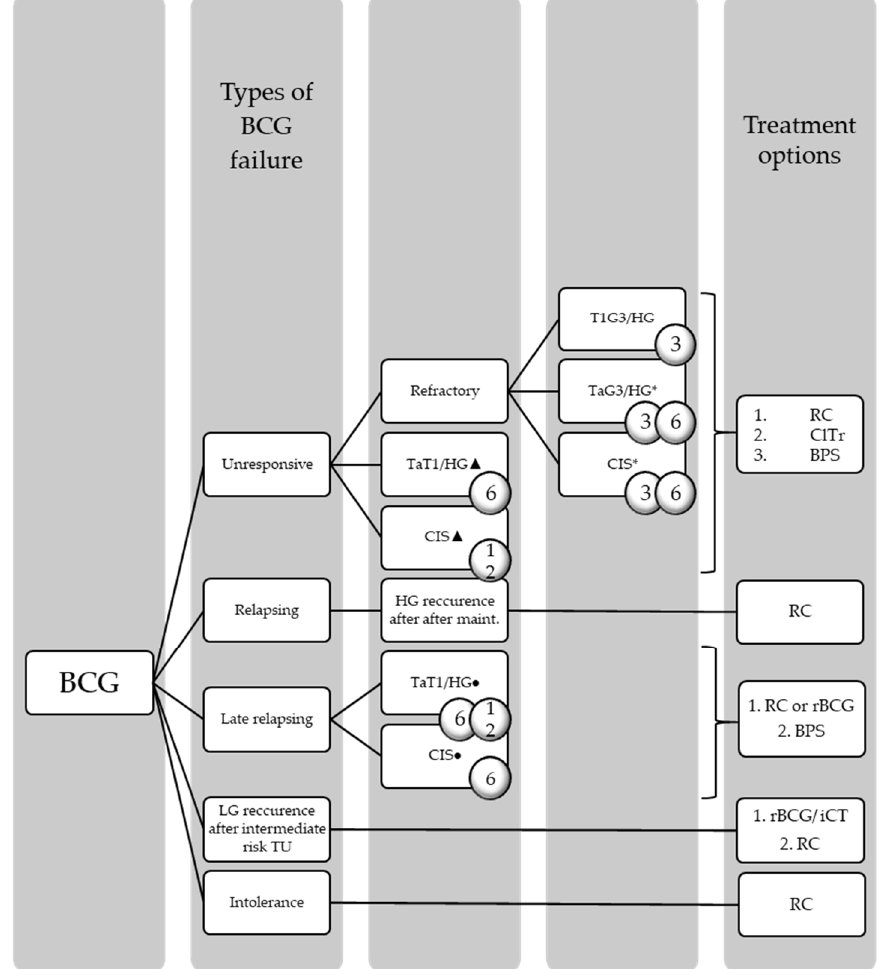
Figure 1. Types of BCG failure and treatment recommendations according to the EAU guidelines on NMIBC = number of months after the initiation of BCG exposure; * after re-induction or maintenance; ▲ = despite adequate BCG exposure (at least 5 of 6 doses of an initial induction course + at least 2/6 doses of a second induction course or 2/3 doses of maintenance; ● = of last BCG exposure; TU = tumor).